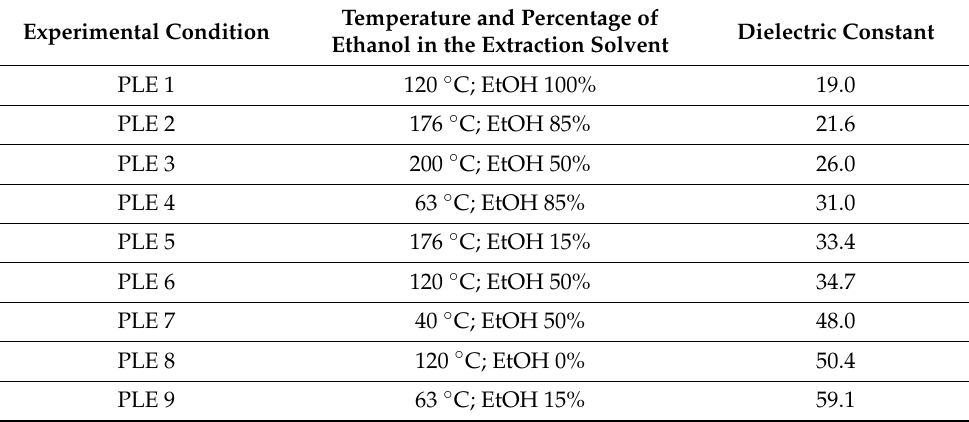
Table 1. Experimental pressurized liquid extraction (PLE)